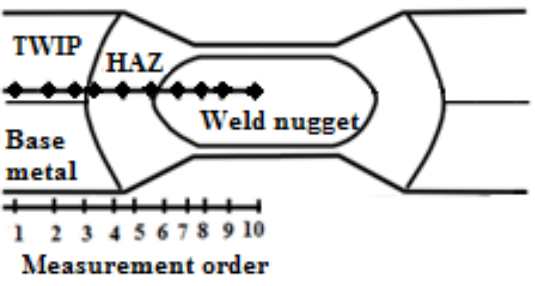
Figure 2. Schematic illustration of hardness measurements.